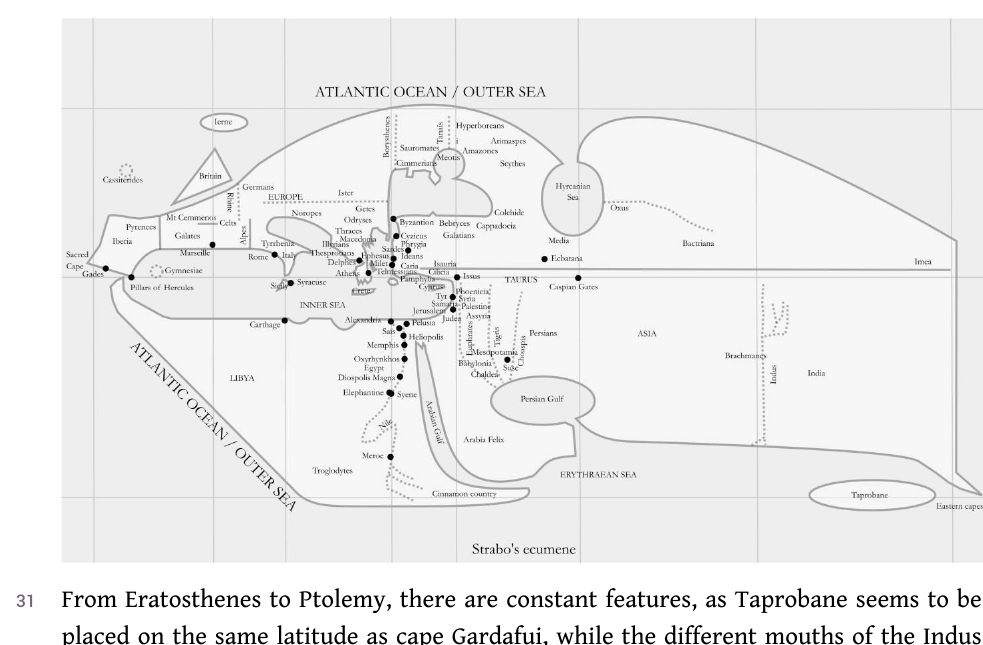
Figure 8. Strabo’s